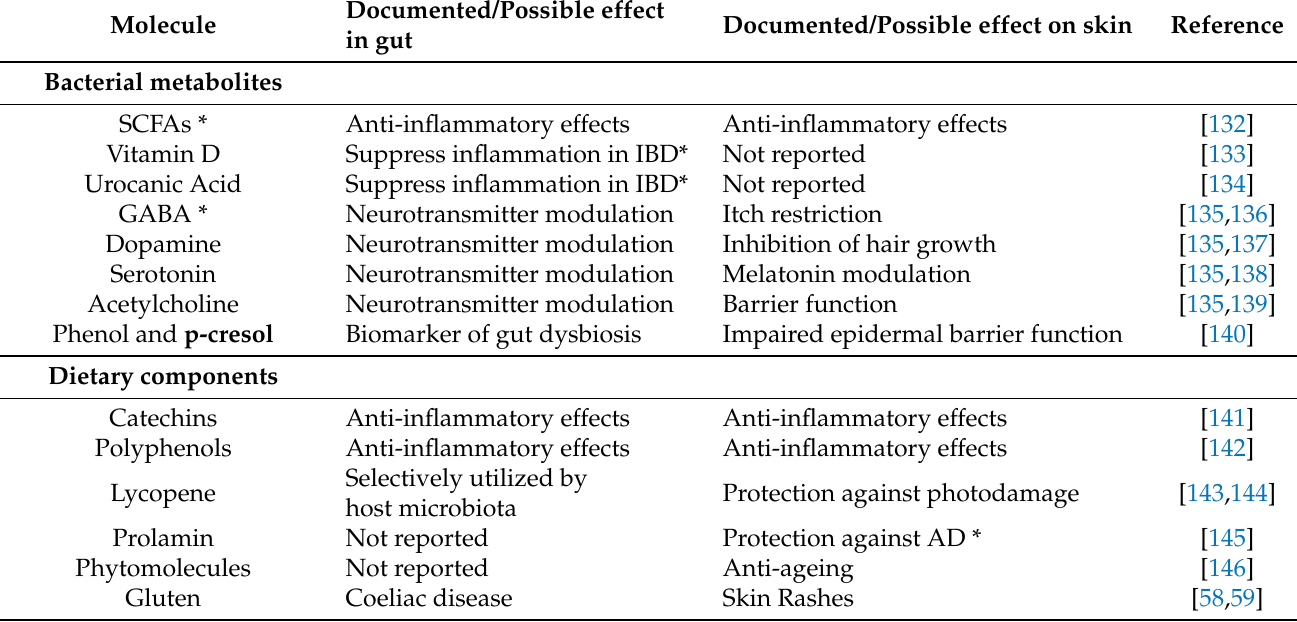
Table 3. Molecules with potential a modulatory effect on skin and gut either directly or indirectly.